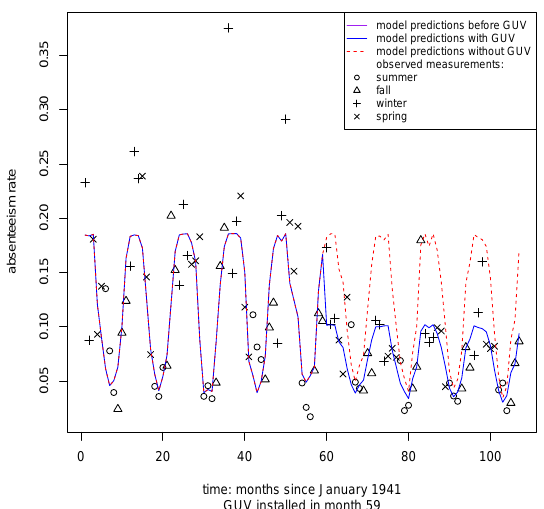
Figure 5. Time series of observed and model-predicted monthly absenteeism rates, and the model- predicted rates had GUV not been installed in December 1945 (dotted red line). The first complete month with GUV was January 1946 (month